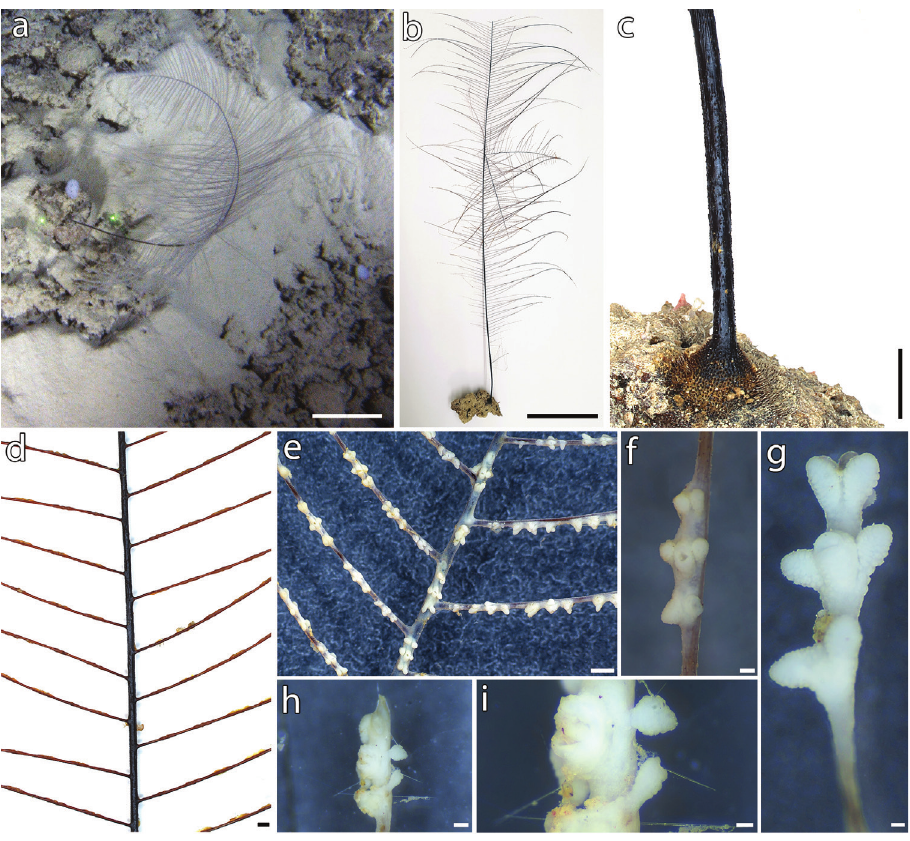
Figure 2. Bathypathes thermophila sp. nov., holotype (MNHN-IK-2016-45) a colony in situ b dry colo- ny c base and stem d alternate arrangement of pinnules e polyps on both stem and pinnules, with f detail of a polyp g pinnular terminal polyp h, i apical polyp of the colony. Scale bars: 10 cm ( a, b ); 5 cm ( c ); 1 mm ( d, e ); 200 μm ( f, h ); 100 μm ( g, i